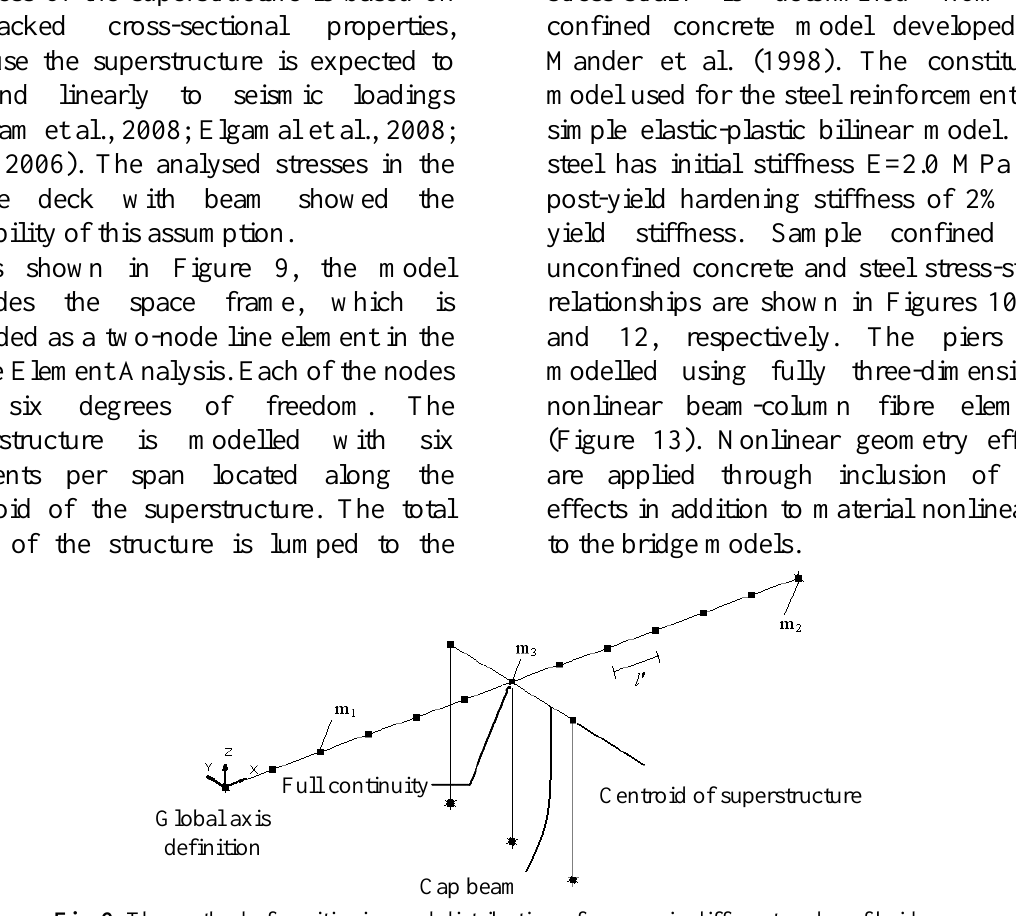
Fig. 9. The method of positioning and distribution of masses in different nodes of